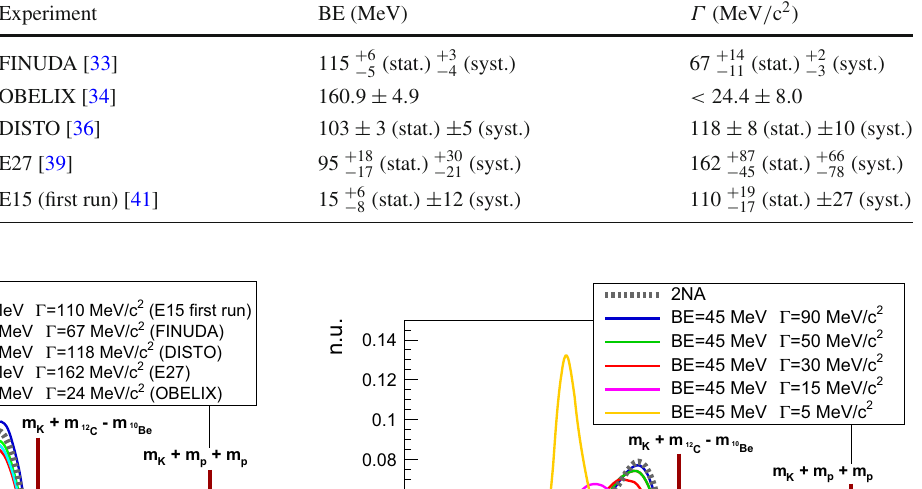
Table 3 Experimental BE and Γ of the K − pp bound state